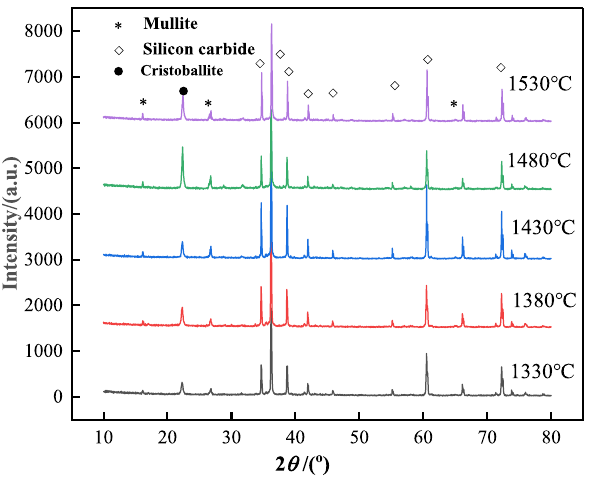
Fig. 4 Powder XRD patterns of the different specimens sintered at 1330, 1380, 1430, 1480, and 1530 °C in an air atmosphere for 2 h